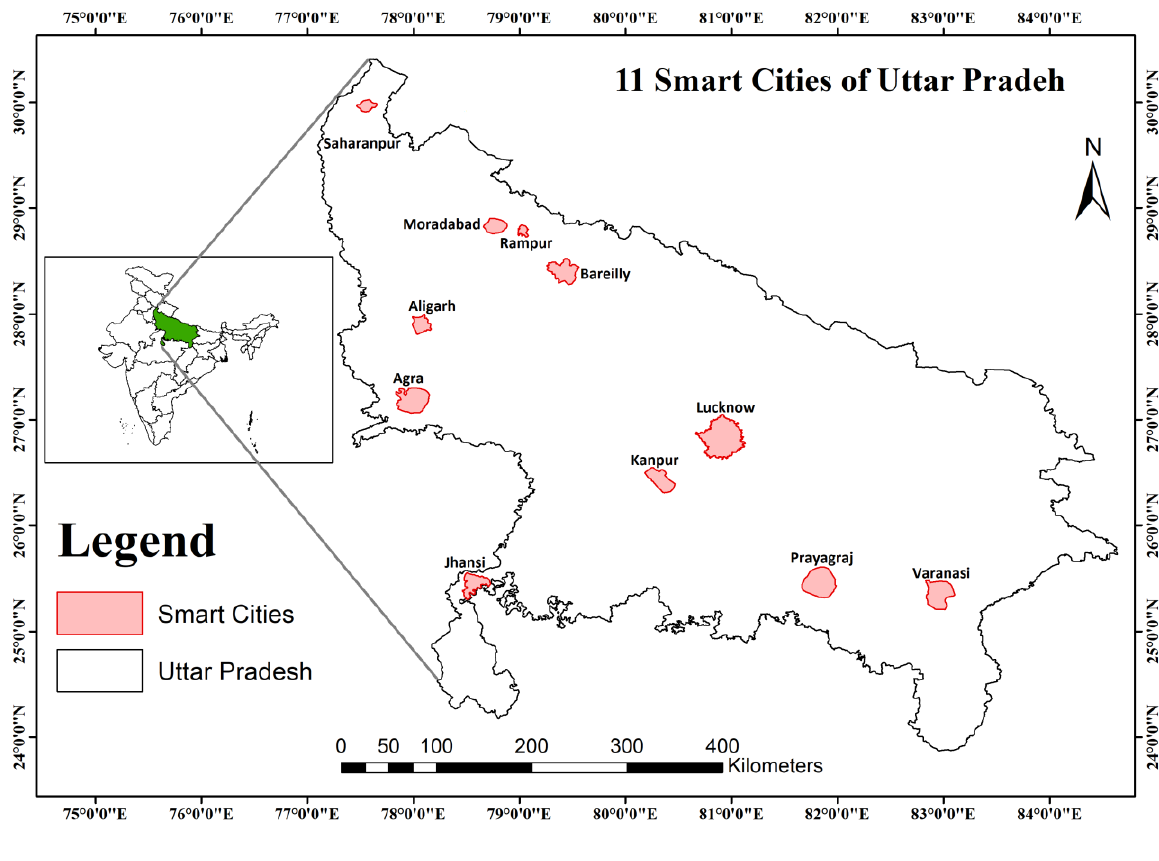
Figure 1 . Study area used in